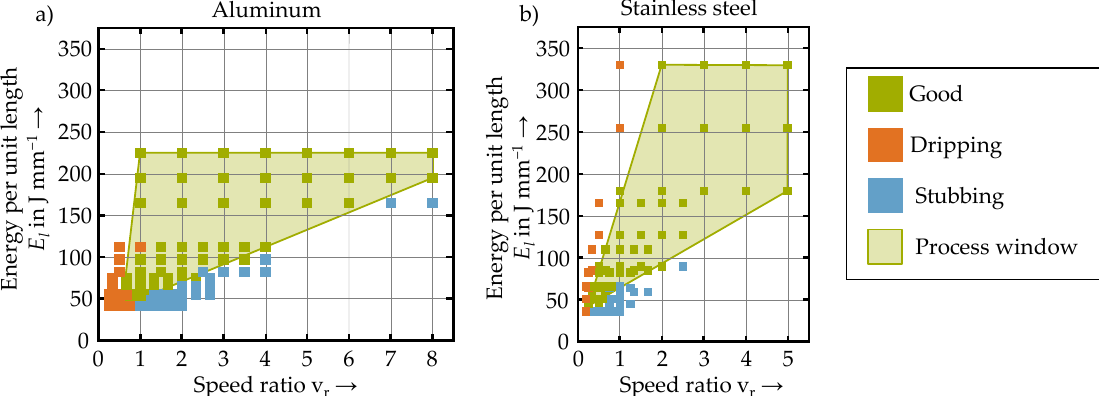
Figure 7. Determined process maps using the parameters speed ratio and energy per unit length for ( a ) aluminum and ( b ) stainless steel.